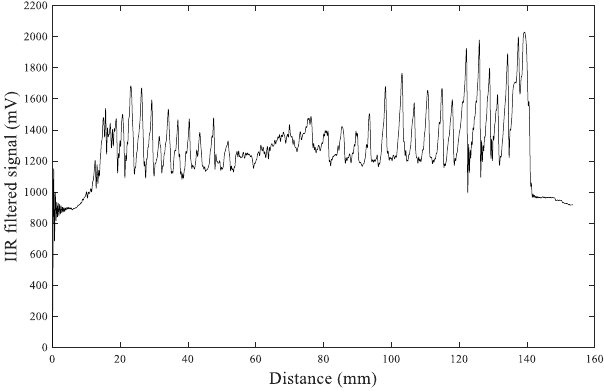
Figure 16. The waveform after IIR filter processing.